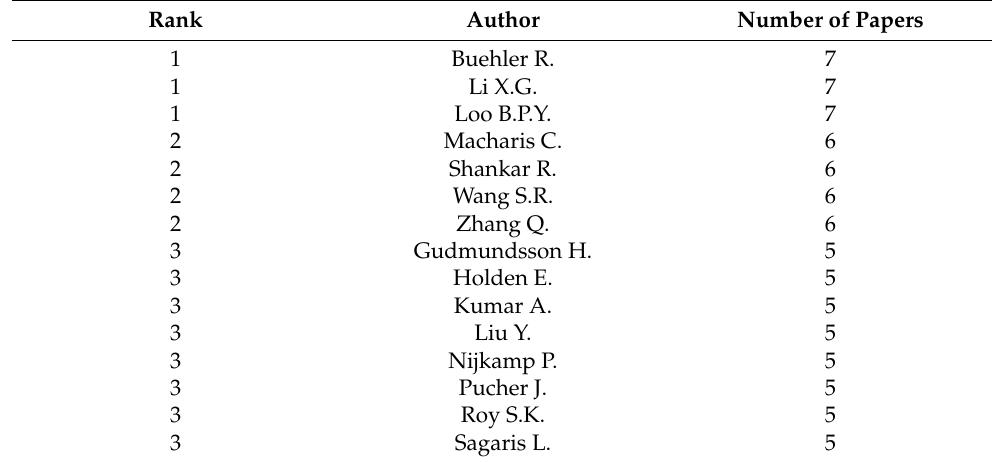
Table 2. Most productive authors by the number of papers.